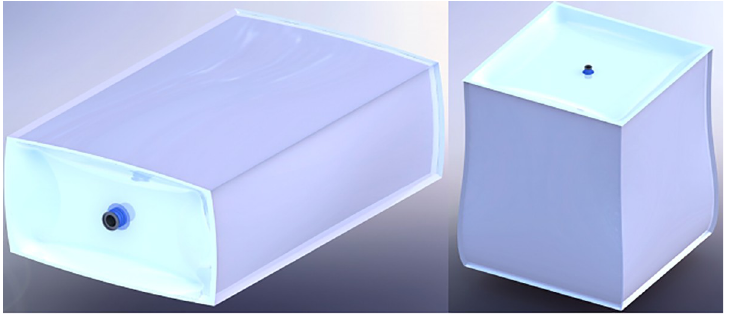
Fig 1. Packaging models of laminated big bags for the storage of soybean